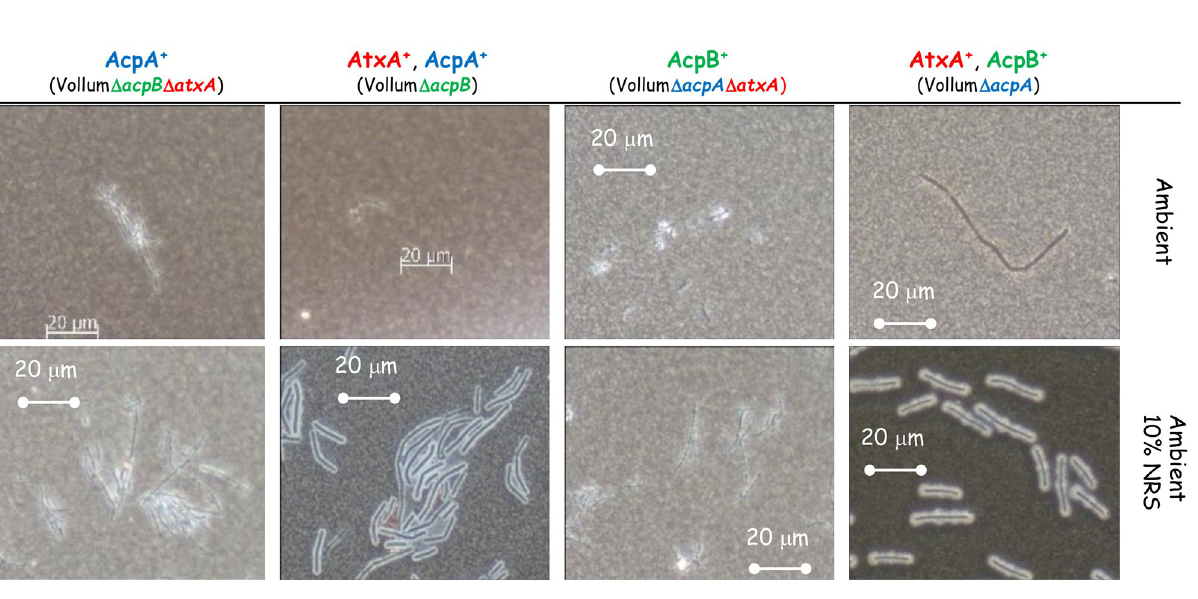
Fig 6. Effect of AtxA on capsule production in response to 10% NRS in ambient atmosphere. Spores of the different mutants (top panel) were seeded into 100 μ l of sDMEM as is or supplemented with 10% NRS and incubated at 37˚C in ambient atmosphere (as indicated on the right) for 24h. Capsule was imaged by India ink negative staining (capsule presence forms a typical bright outer